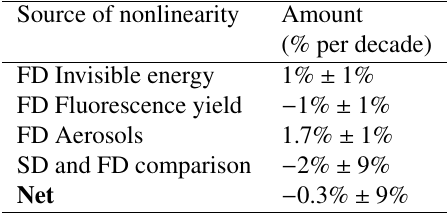
Table 1. Sources of energy-dependent reconstruction bias in TA